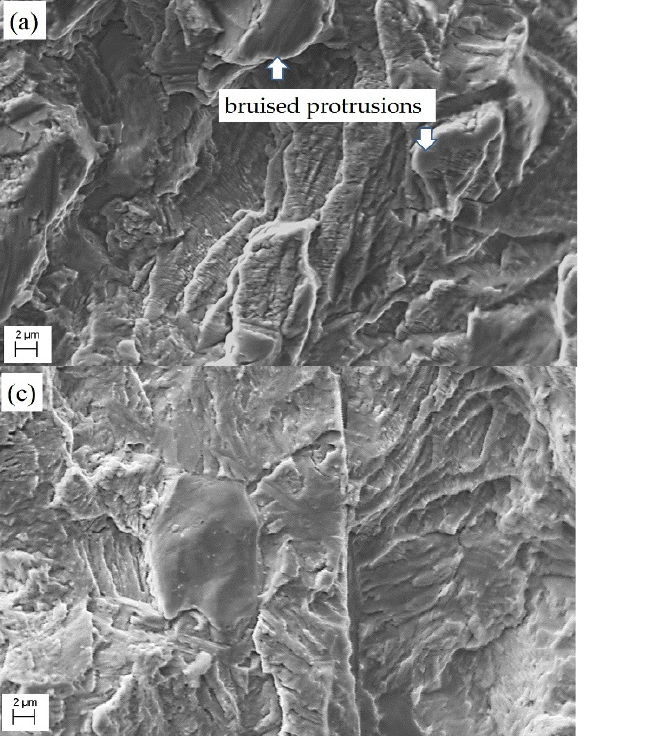
Figure 10. SEM fractography of specimens of 17H1S steel ( a,b ) in the AR state and ( c , d ) after LTO underwent the FCG resistance test at a frequency of 10 Hz and values of the stress ratio of ( a , c ) 0.1 and ( b , d ) 0.5. The SEM images correspond to the Δ K level of about 23–25 MPa m 1/2 . The features of the fatigue fracture surfaces of 17H1S steel specimens cut from both the pipe in the AR state and the LTO pipe in the positions mentioned above and also undergoing the FCG resistance test at R = 0.5 were analyzed because the highest crack growth rate was obtained for these specimens (Figures 11 and 12).